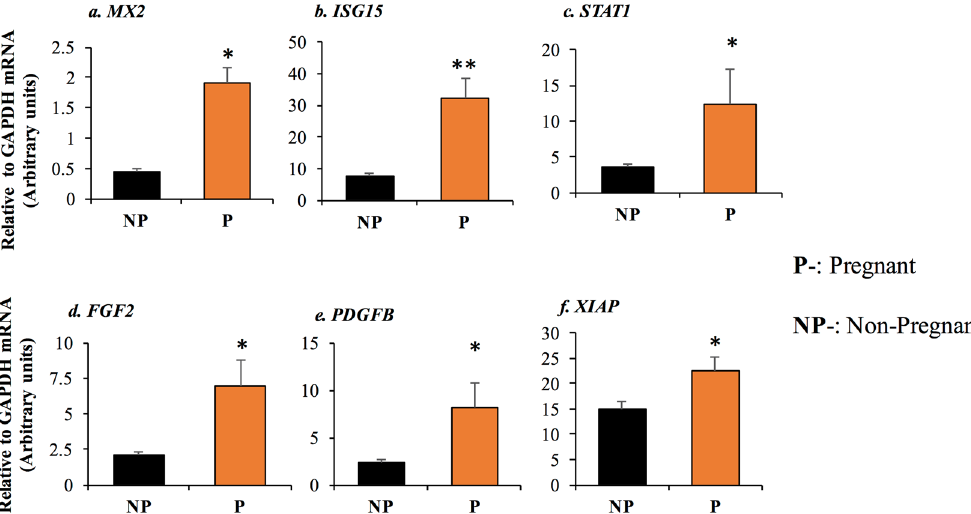
Figure 7. Differential gene expression in pregnant and cyclic CL. The levels of ( a ) ISG15 , ( b ) MX2 , ( c ) STAT1 , ( d ) FGF2 , ( e ) PDGFB , and ( f ) XIAP mRNAs in day 18 CL from pregnant (P) and cyclic (C) cows. The total RNA was isolated from the tissue, and the mRNA expression were determined using qPCR. Asterisks indicate significant differences between pregnant and cyclic CL ( * P < 0.05, ** P < 0.01, *** P < 0.001).